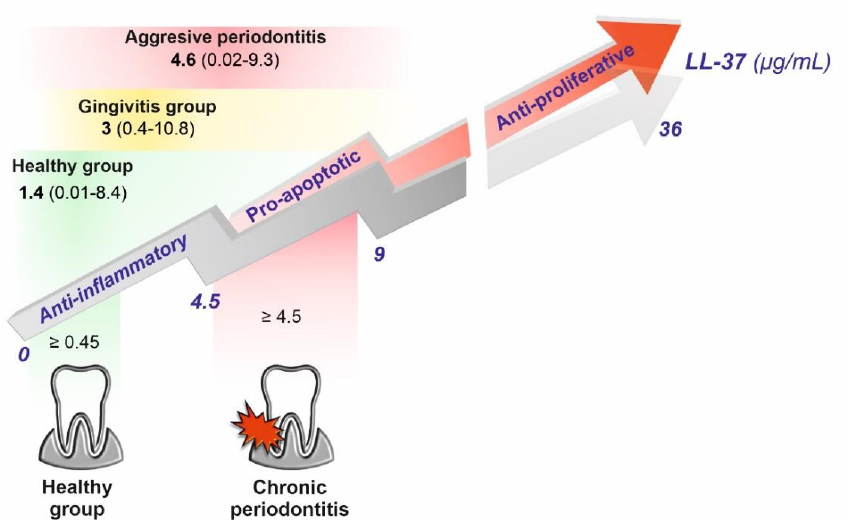
Figure 9. Illustration of concentration-dependent anti- inflammatory (exerted at a concentration ≥ 0.45 μg/mL or 0.1 μM), pro - apoptotic (exerted at a concentration ≥ 4.5 μg/mL or 1 μM), and anti - proliferative (exerted at a concentration ≥ 36 μg/mL or 8 μM) activity o f LL-37 in gingival crevicular fluid (GCF) postulated by Jonsson at al. [33]. The authors correlated the anti-inflammatory and pro- apoptotic values with concentrations of LL-37 in GCF patients with chronic periodontitis and the healthy control group from the reference [33] — the lower part of the image (the size of areas high- lighted in green and red represent the upper and lower quartiles of LL-37 concentrations in the healthy and chronic periodontitis group, respectively). The upper part of the image shows LL-37 concentrations in GCF patients with gingivitis and aggressive periodontitis in comparison to the healthy control group from the reference [33] (the size areas of highlighted in green, yellow, and red and the higher color intensity represent the range of LL-37 concentrations (the values in parenthe- ses) and the means, respectively).